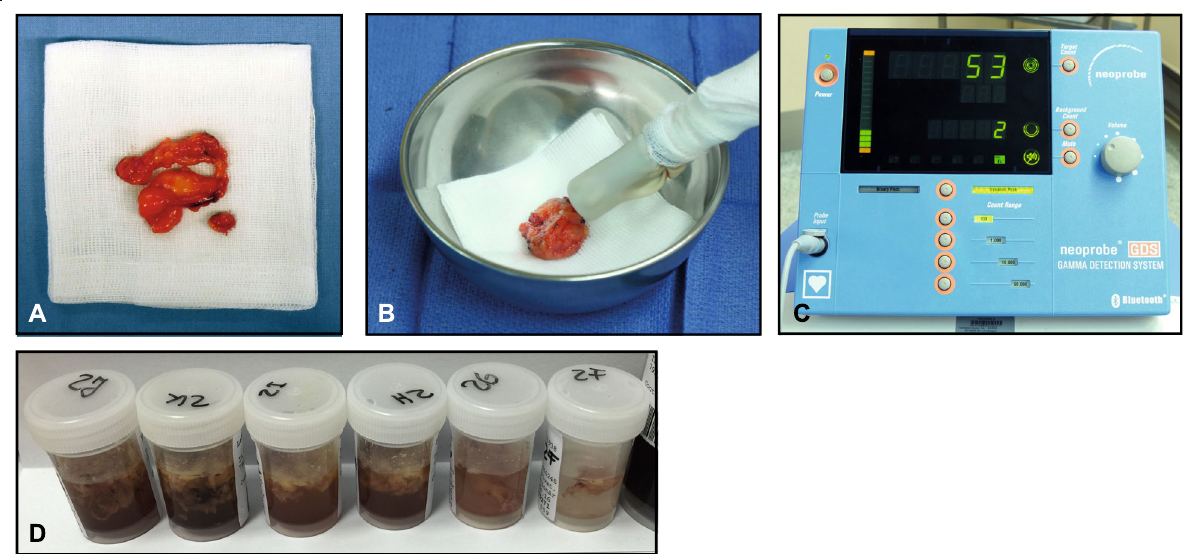
Fig. 3 a Representative resected tissue sample from a subregion consisting of lymph nodes and fibrofatty tissue. b , c γ -probe measurement (counts per second) from a tissue sample. d Representative collection of 6 tissue samples from 6 subregions for analysis of tracer uptake in the germanium detector